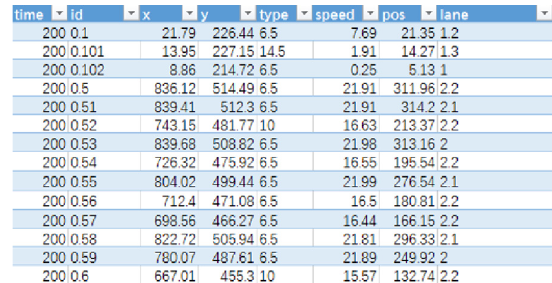
Figure 5 Road network constructed by SUMO